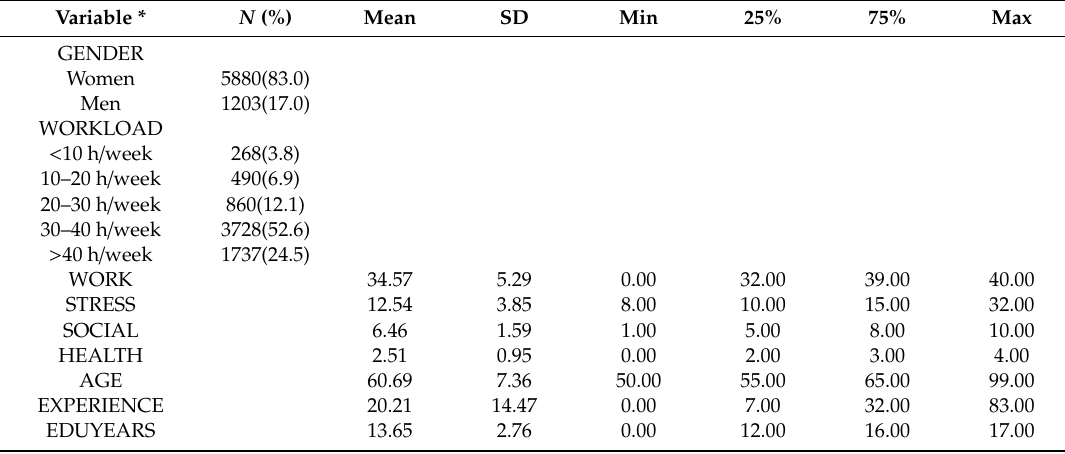
Table 2. Descriptive Statistics of